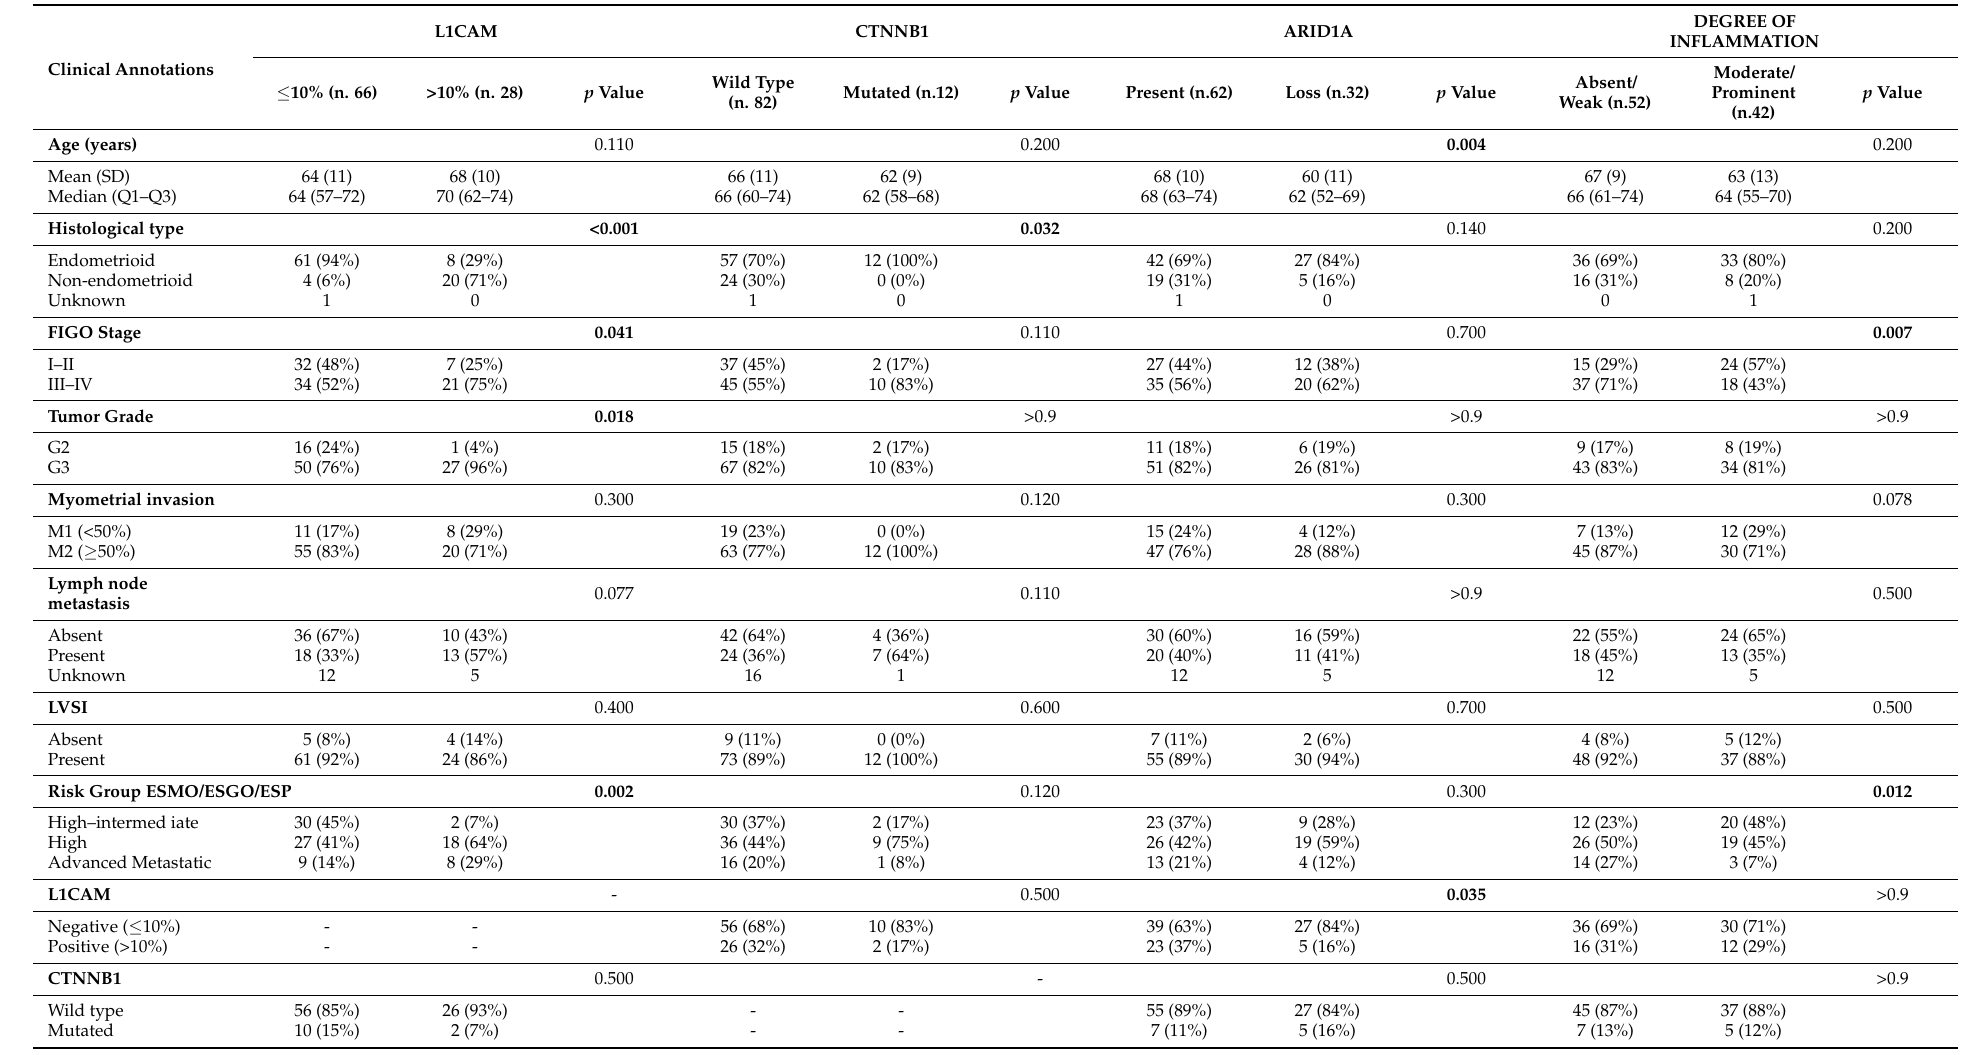
Table A4. Correlation between additional biomarkers and clinicopathological/molecular characteristics of the Brescia